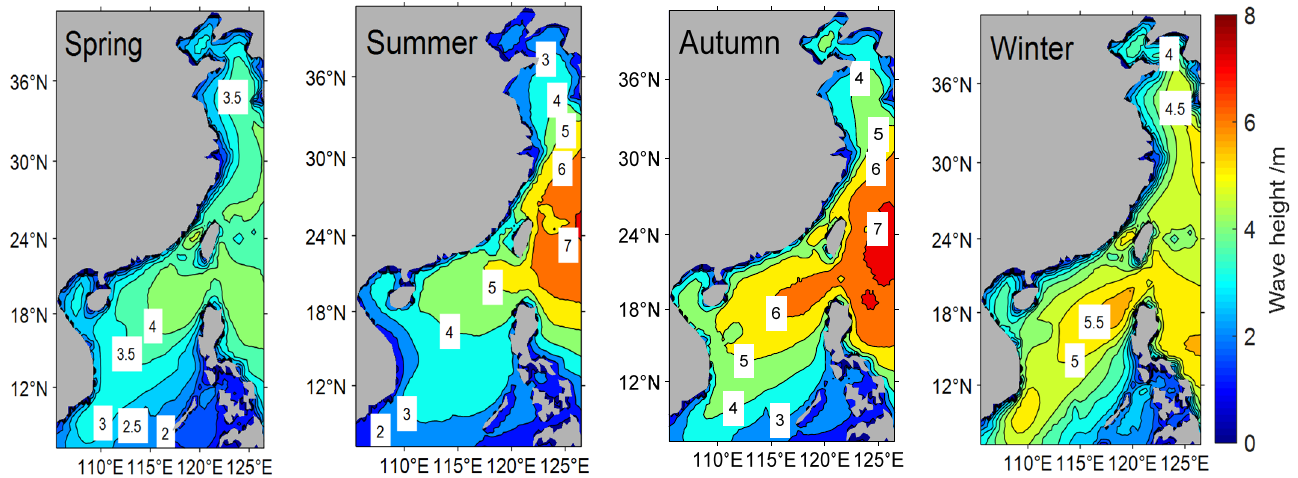
Figure 11. The distribution of seasonal mean extreme wave height at the 99% quintile ( H 99 ).